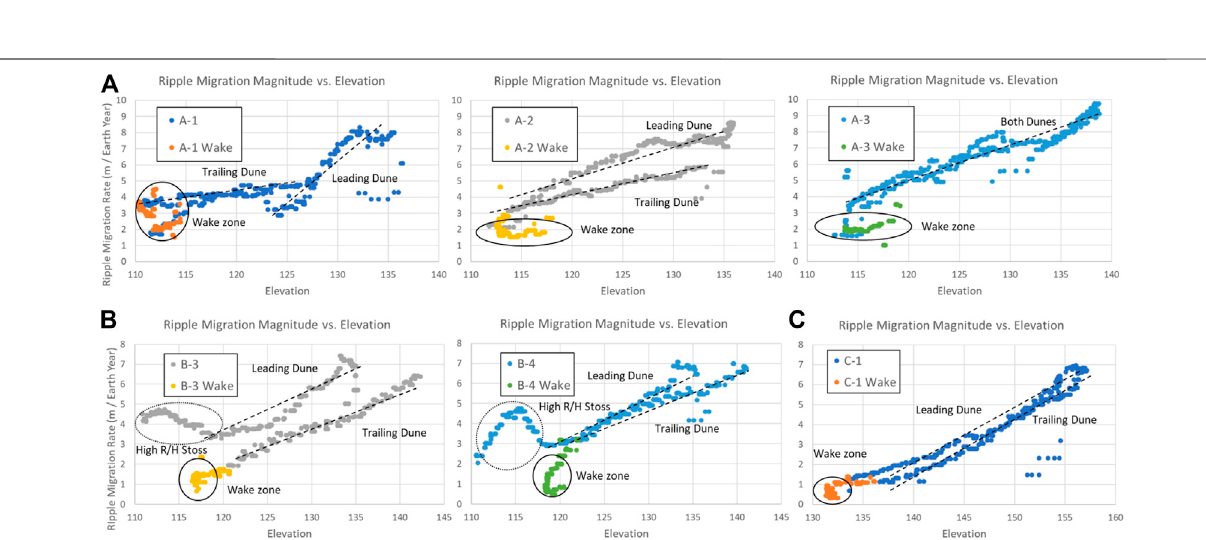
fl ank of the southern dune, ripples initiate on a plinth-like structure beneath the extended lee-slope of the upwind large dune. At this point of incipience, winds indicated by 2-D ripples are oriented toward ∼ 200 ° ( Figure 12 ). As shown in Figure 12 , winds indicated by 2-D ripples on the northern slope become aligned with dominant winds within 100 m of formation. The